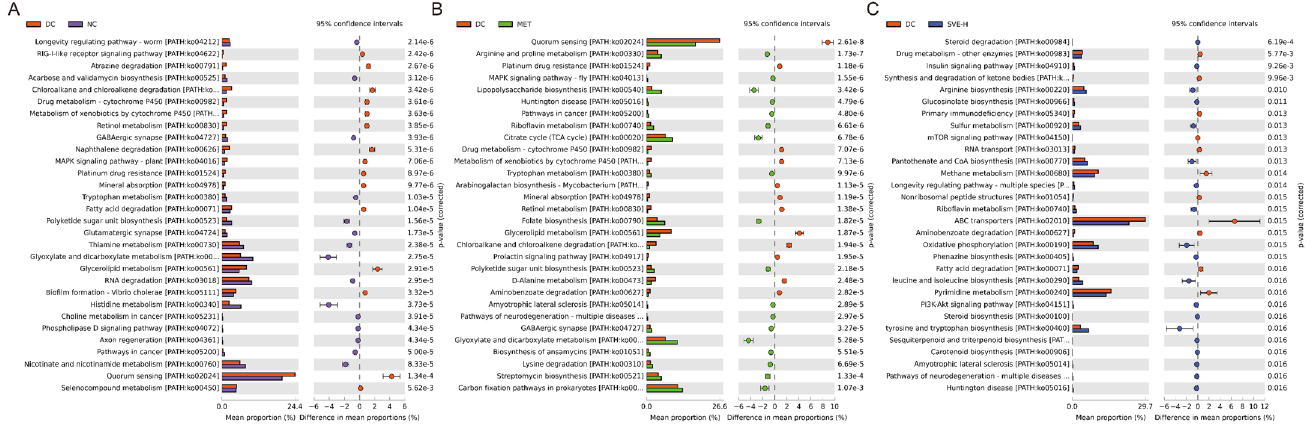
Figure 5. Function prediction of the gut microbiota revealed by PICRUSt2. DC versus NC ( A ), or MET ( B ), or SVE-H ( C ) group. Note: p < 0.05, confidence intervals = 95%.